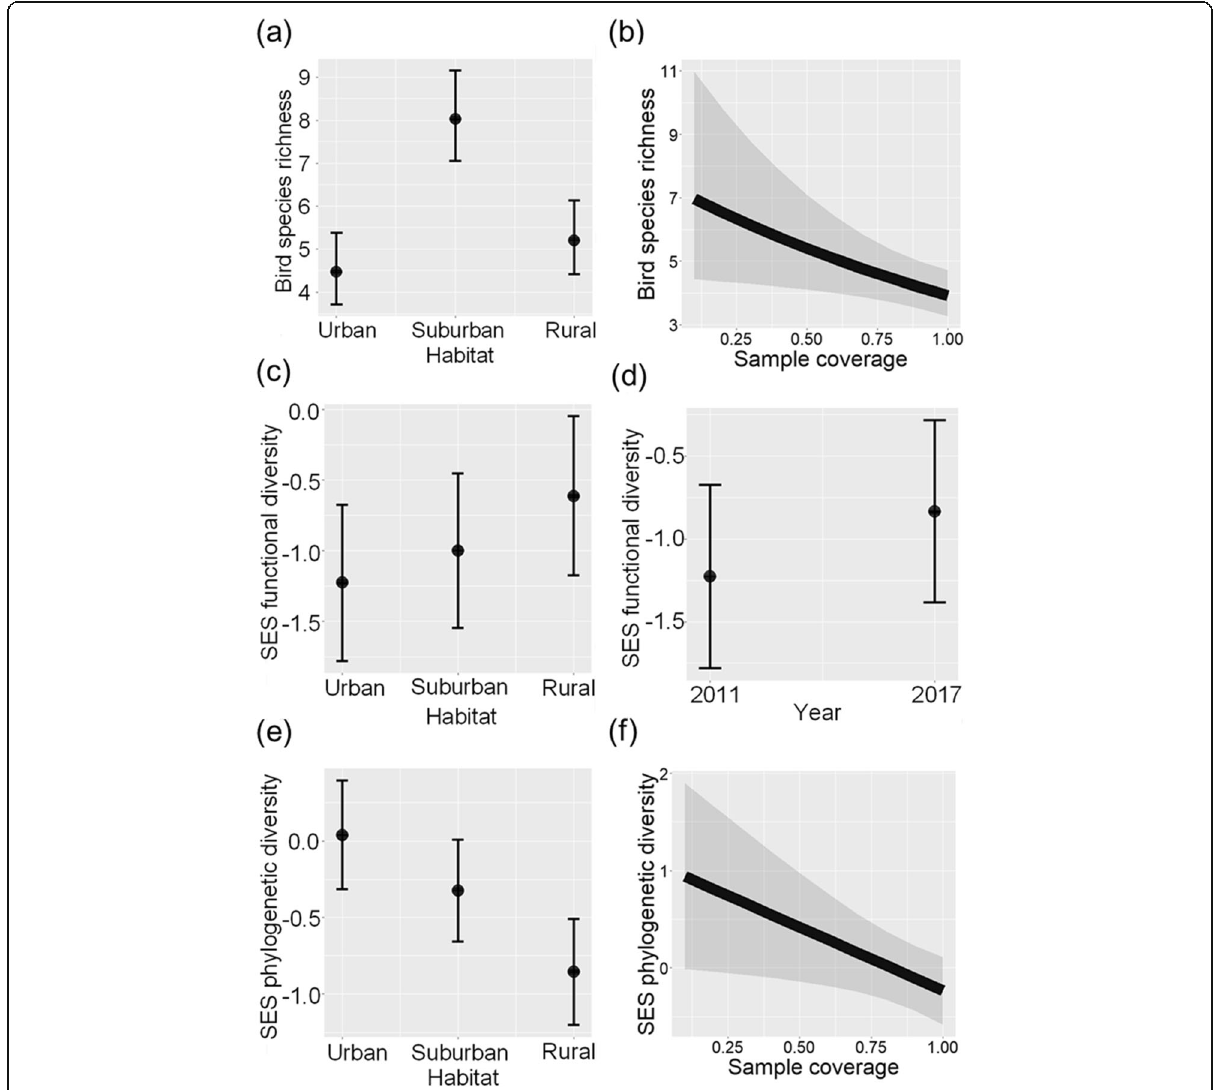
Fig. 2 Bird species richness variation between a habitat types and b in relation to sample coverage; SES of functional diversity variation between c habitat types and d years; and SES of phylogenetic diversity variation between e habitat types and f in relation to sample coverage along rural- urban gradients in central Argentina. SES, standardized effect size; values higher than zero indicate a greater diversity than expected by the null model, whereas values lower than zero indicate lower diversity than expected by the null model. Points are means, and vertical lines and grey areas are confident